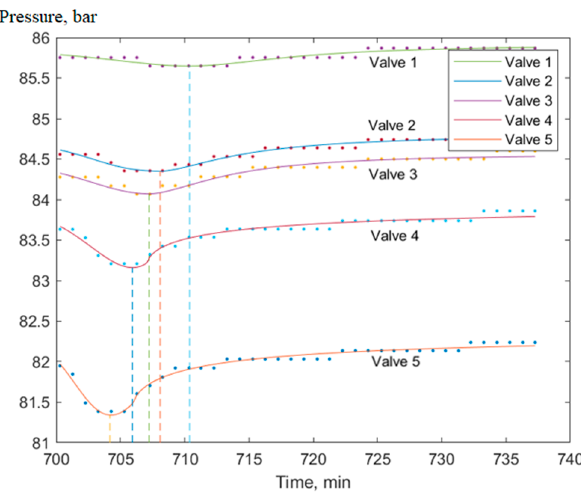
Figure 7. Approximation of curves p i ( t ) (valves 1–5). Depression waves. Example 5. The compression wave gradually smooths out as it moves up against the current.